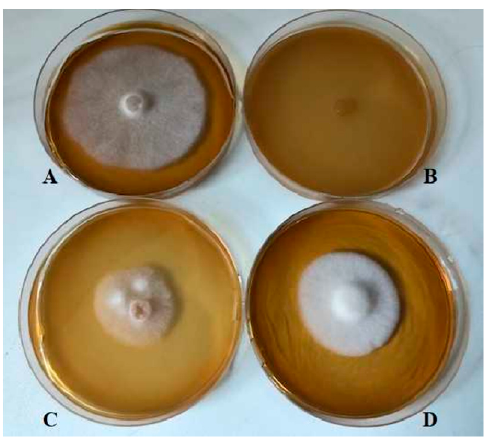
Figure 2. Inhibitory activity after 6 days on MEA agar plates of L. kunkeei K7 against A. apis DSM 3116. A : A.